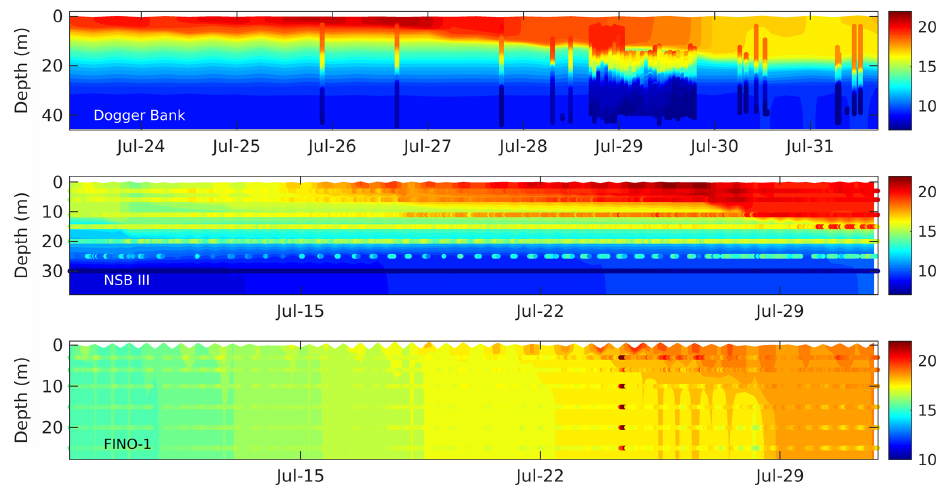
Figure 3. In situ measured and model simulated water temperatures (in ◦ C) in July. In the Dogger Bank (upper panel), measurements were obtained by a CTD profiler during the Poseidon campaign. At the MARNET stations NSB III (middle panel) and Fino-1 (lower panel), temperatures were measured in fixed water